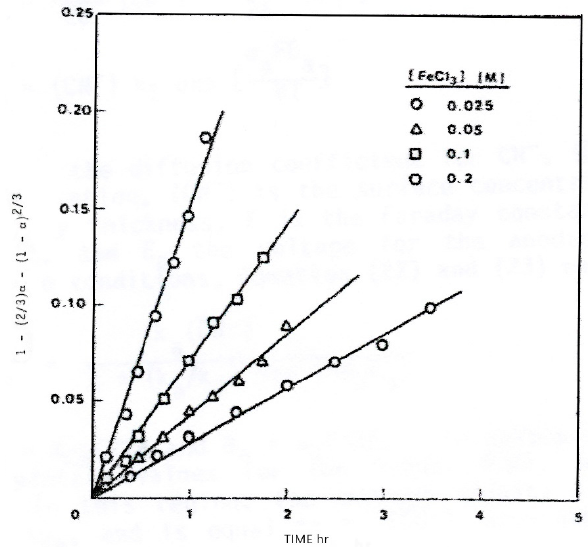
Figure 2. Data of Fuerstenau et al. [34] showing correlation using the diffusion equation for isometric particles for four FeCl 3 concentrations (monosized galena, 35 × 48 mesh, 4.0 M NaCl. 323 °K (50 °C)).